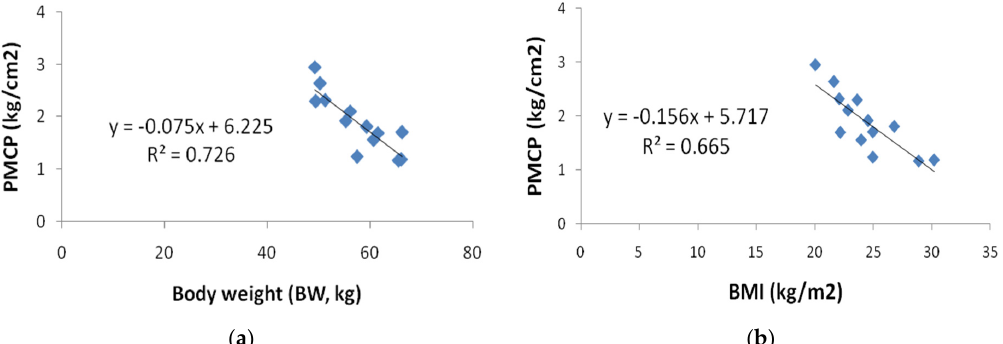
Figure 5. ( a ) The correlation between body weight (BW) with pain minimum compressive pressure (PMCP); ( b ) The correlation between body mass index (BMI) with pain minimum compressive pressure (PMCP).